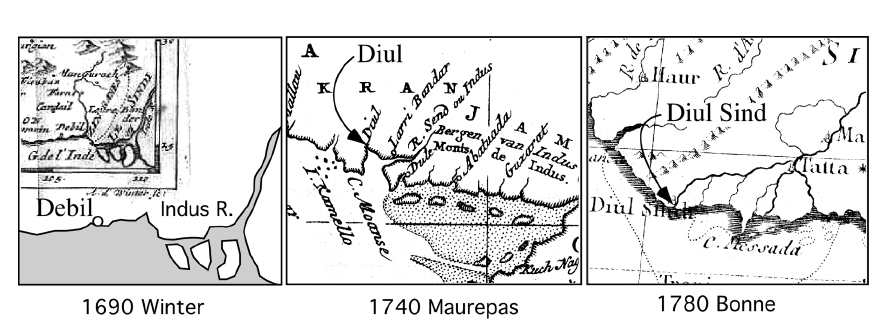
Fig. 2. Maps in 1690 and 1740 show Debil near the current location of Karachi. Other maps show it on a dis- tributary of the Indus. An earthquake occurred there in 1668 and another is alleged by Thomas Oldham (1883) to have occurred in 893 but the event he invokes occurred in an Armenian town with a similar name (Ambraseys, 2004). The city is last mentioned in the 18thcentury (Yule et al. ,